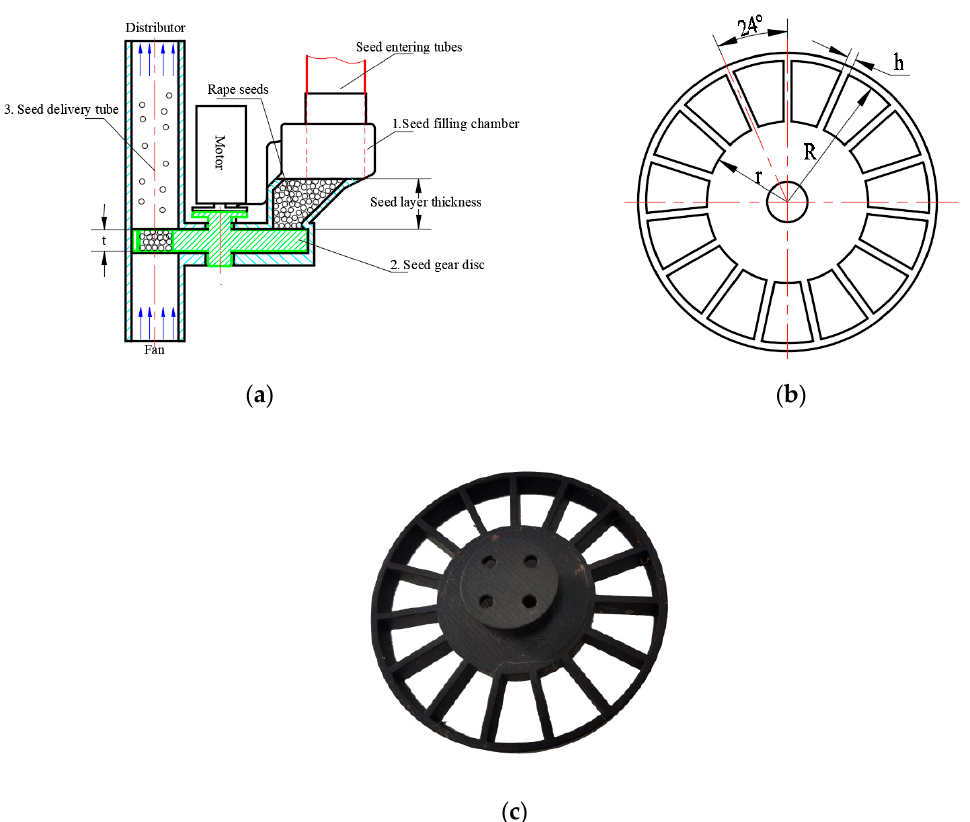
Figure 2. Seed feeding component. ( a ) Schematic diagram (t is the axial thickness of the seed gear disc); ( b ) Seed gear disc schematic (R is the outer diameter of the seed gear disc, r is the inner diameter of the seed gear disc, and h is the gear thickness). ( c ) Real seed gear disc.